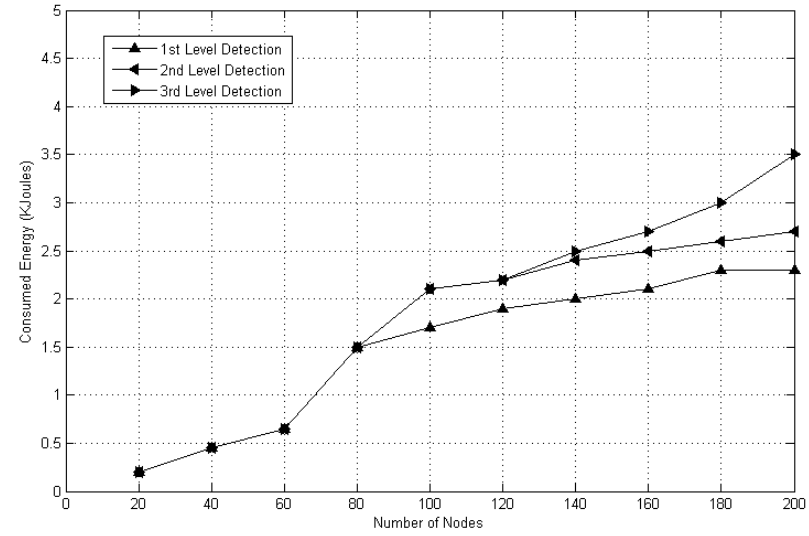
Figure 11. Energy consumption at different stages of the DT